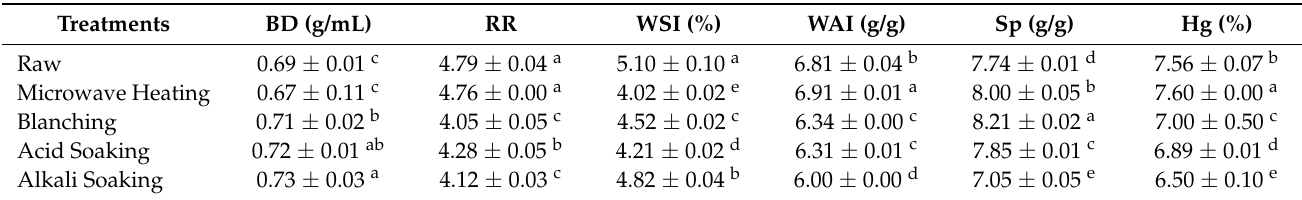
Table 1. Functional properties of raw and processed cabbage powder.